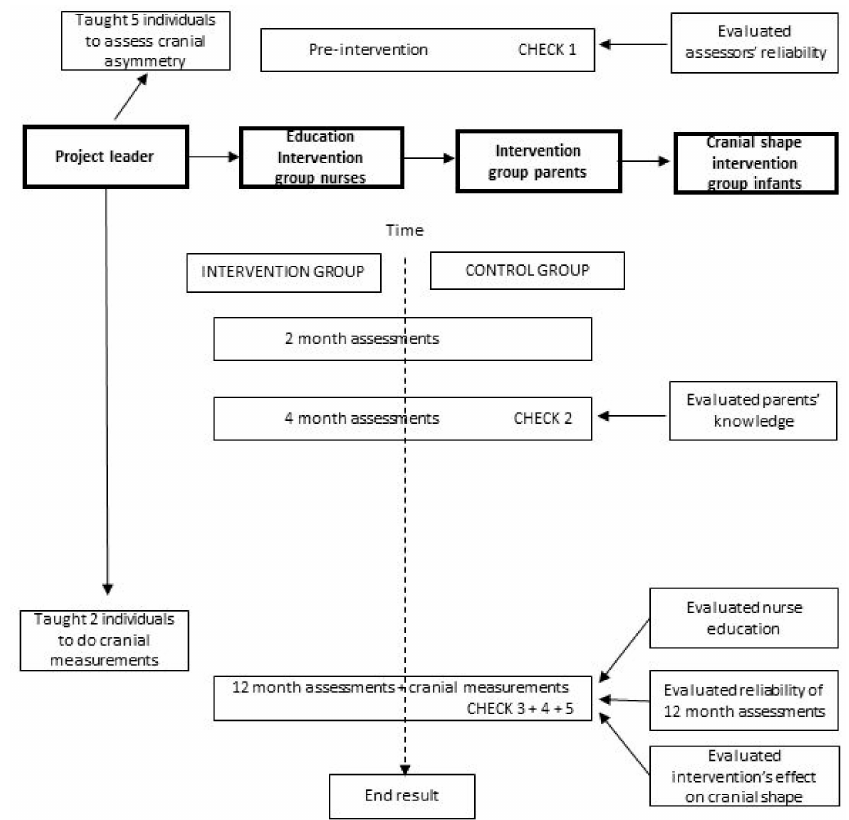
Figure 1. Design of the